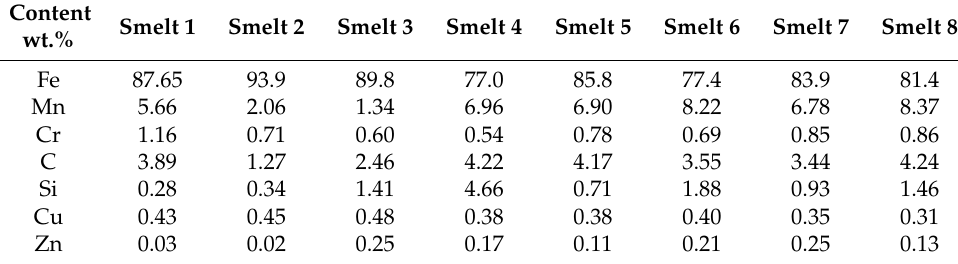
Table 4. Chemical analysis of the metallic alloy. Content